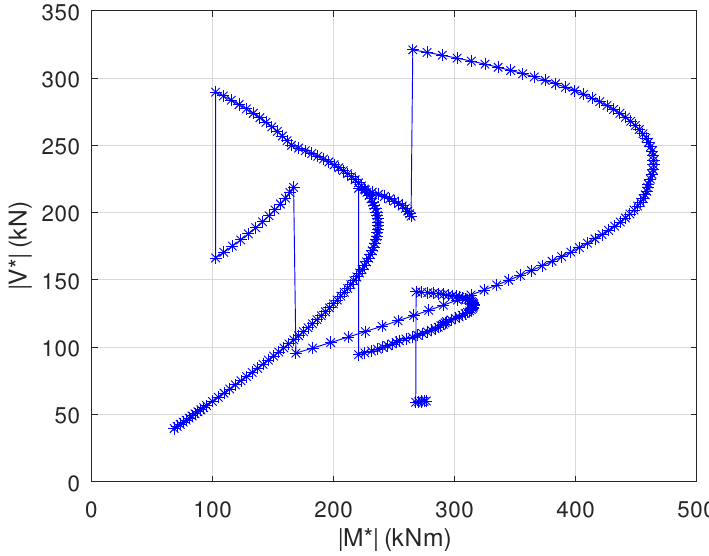
Figure 9. V ∗ versus M ∗ for x veh = 10.0 to 34.5 m in steps of 0.1 m. Figure 10 shows the shear V ∗ of the section which is plotted against the longitudinal strain in concrete at the mid-depth of section, (cid:101) x . The reduced ultimate shear capacity φ V u is also plotted in the same figure. The analysis shows that the shear capacity is exceeded (i.e., V ∗ > φ V u ) when the first axle crosses the section. | M ∗ | is 286 kNm, | V ∗ | is 141 kN and φ V u is 126 kN.